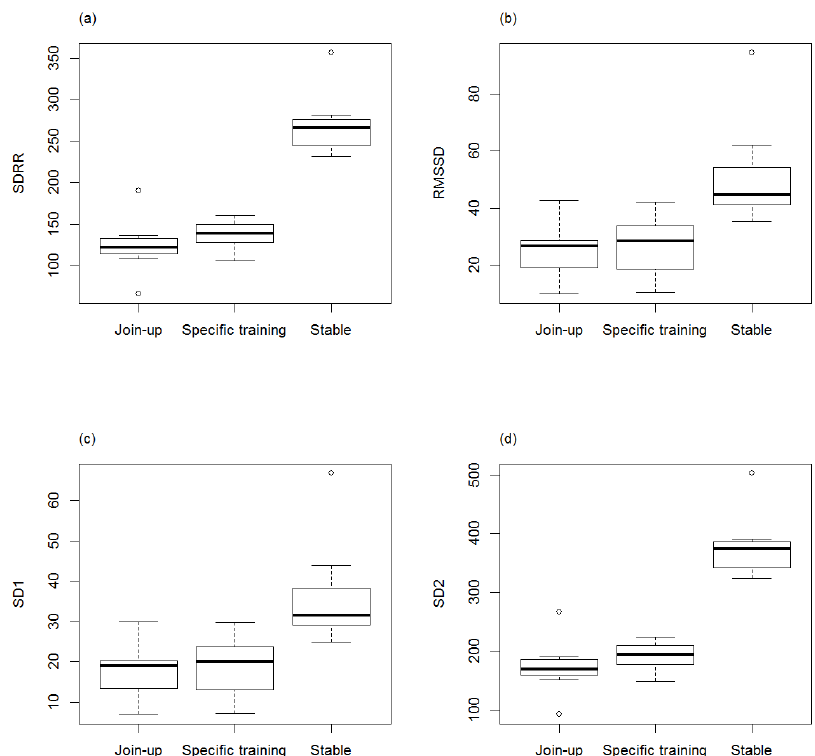
Figure 5. Standard deviation of the RR interval (SDRR) ( a ), root mean square of successive RR differences (RMSSD) ( b ), and the geometric means standard deviation 1 (SD1) ( c ) and 2 (SD2) ( d ) before training (Stable), during their first Join-Up ® (Join-up) and during the rest of the training session (Specific training). No statistical difference was observed between first Join-Up ® (Join-up) and during the rest of the training session (Specific training). Analysed using generalized linear mixed models (GLMM) and the Wilcoxon signed-rank test.